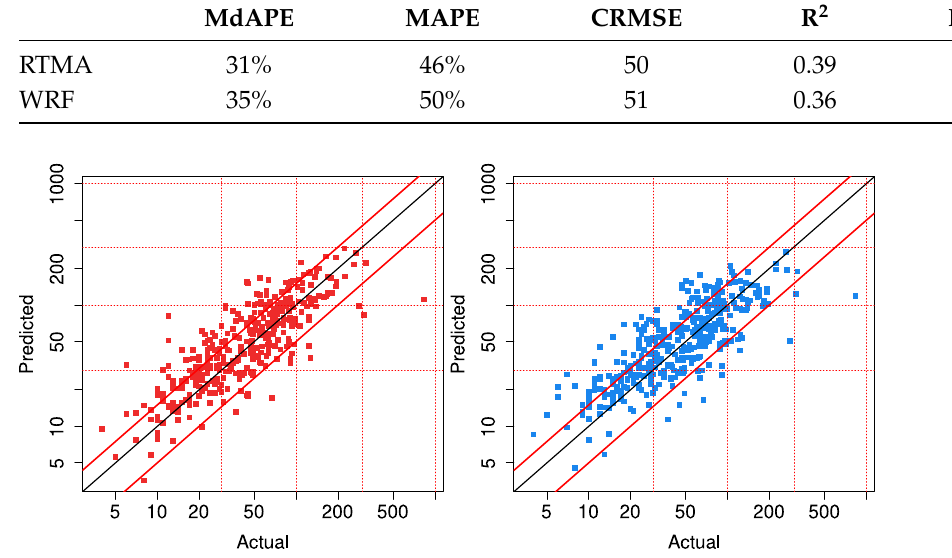
Figure 3. Scatterplots of cross-validation predictions versus actual outages for all thunderstorm events for RTMA- (red, ( left )) and WRF (blue, ( right ))-based outage prediction